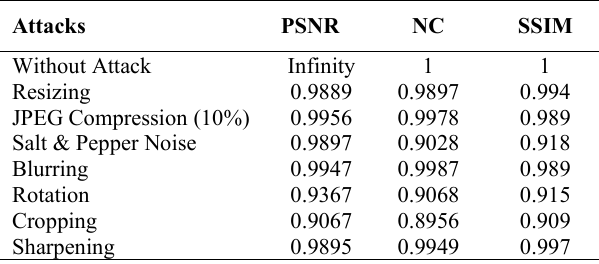
Table 4. The result of common image processing attacks on Lena